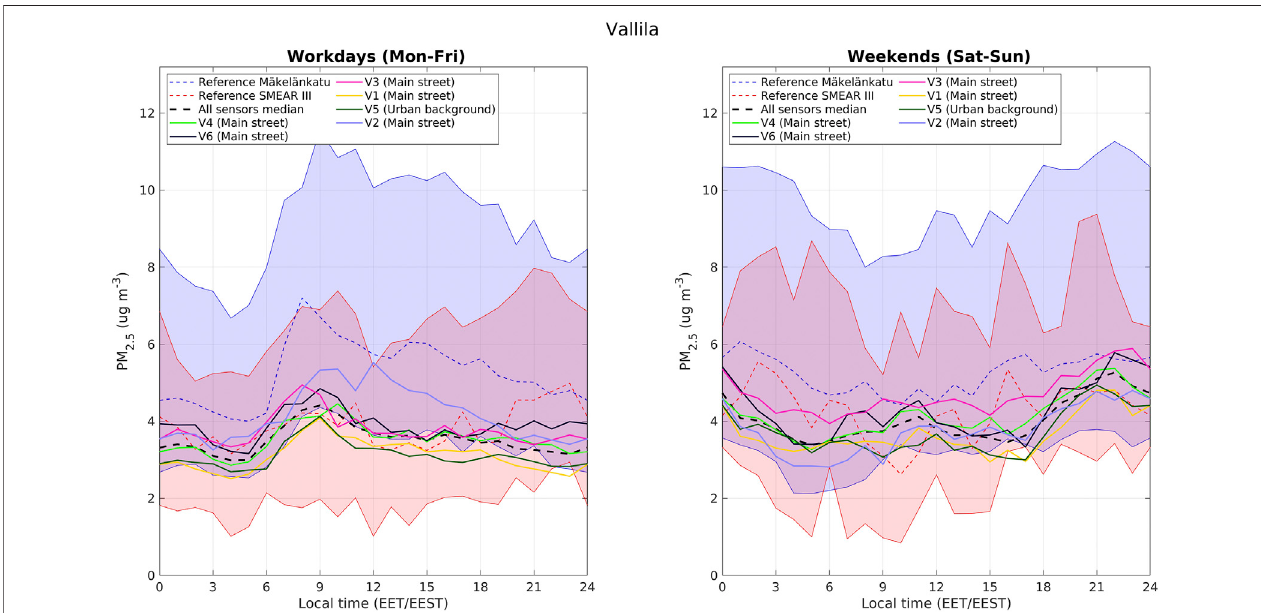
FIGURE 7| Median diurnal cycle of PM2.5 massconcentration during 5-month period (1.8.-31.12.2020) for sensors located in Vallila (left) workdays (Mon-Fri) and (right)weekends(Sat-Sun).Referencemeasurementsshowmedian(dashedline)and25thand75thpercentiles(shadedarea)fromnearestreferenceinstruments.Black dashed line shows median diurnal cycle calculated for all data from that location.